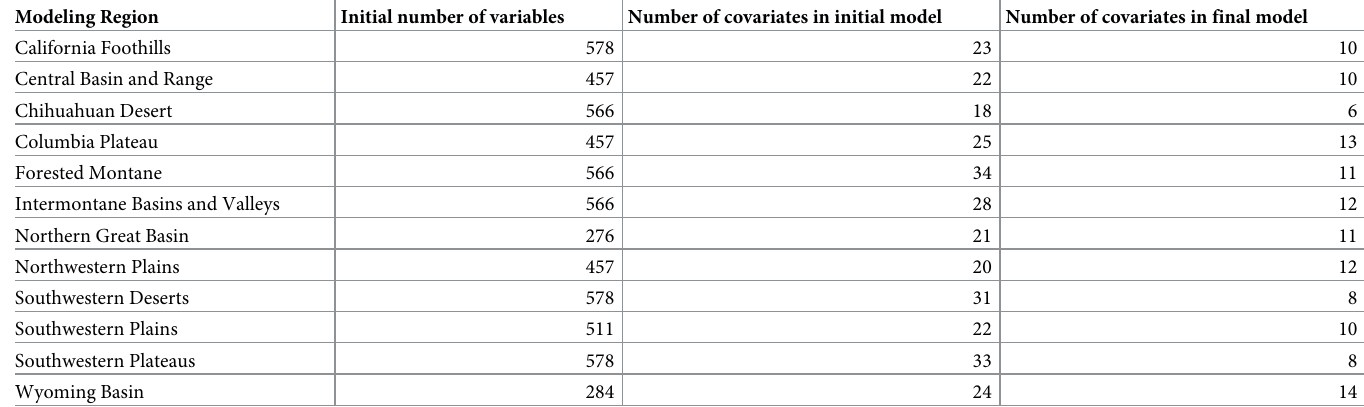
Table 2. Number of initial variables considered, number of covariates in the initial model, and number of covariates in each modeling region’s final